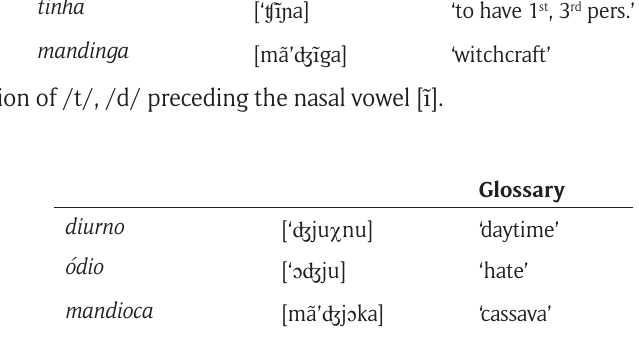
Table 7: Palatalization of /t/, /d/ preceding the palatal glide